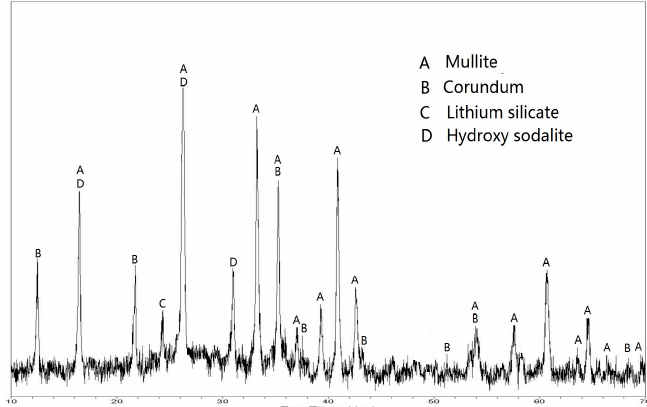
Figure 5. XRD pattern of DCFA.